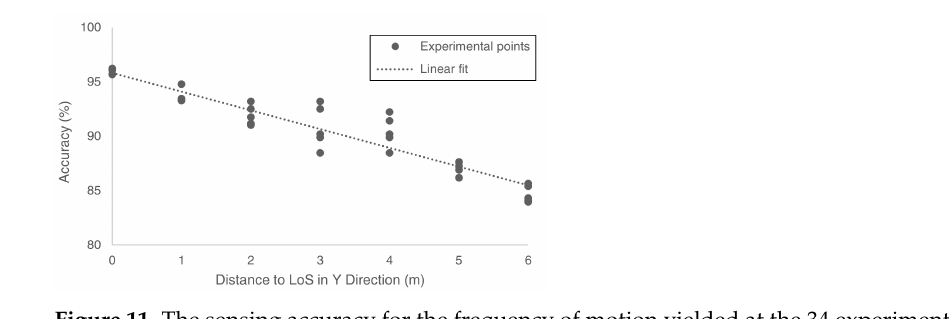
Figure 11. The sensing accuracy for the frequency of motion yielded at the 34 experimental points versus their distance to origin in the Y direction and the calculated linear relationship.